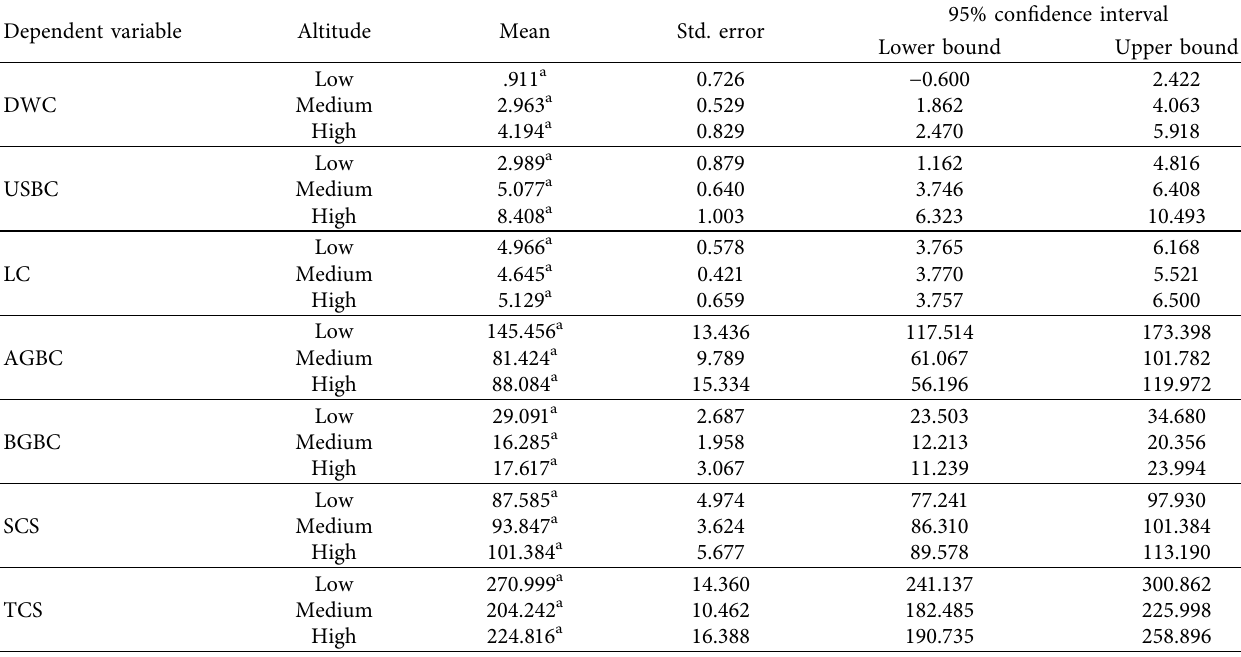
Table 9: Estimated marginal means of altitude in Ziba forest.